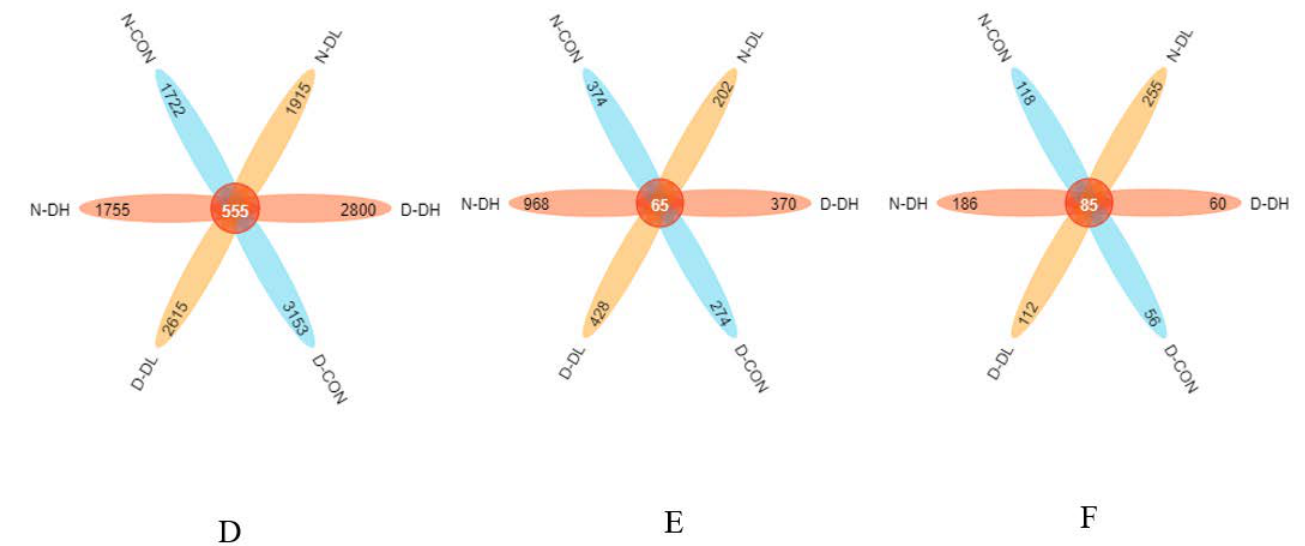
Figure 2. Each color block represents a group. The overlapping area between the color blocks indicates the ASV/OTU shared by the corresponding groups, and the number of each block indicates the number of ASV/OTU contained in the block. In the figure, ( D ) represents bacteria, ( E ) represents fungi and ( F ) represents protozoa; D represents 12 h of the day, and N represents 12 h at night.